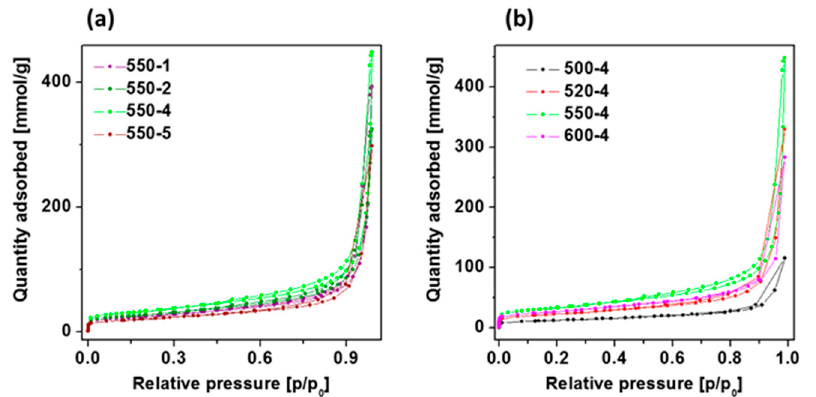
Figure 3. Adsorption-desorption isotherms of polymeric carbon nitride prepared at ( a ) 550 ◦ C with different heating rate conditions and ( b ) under different temperatures (500–600 ◦ C) with heating rate of 4 ◦ C/min. Table 4. Brunauer–Emmett–Teller (BET) surface area of polymeric carbon nitride prepared under different conditions.